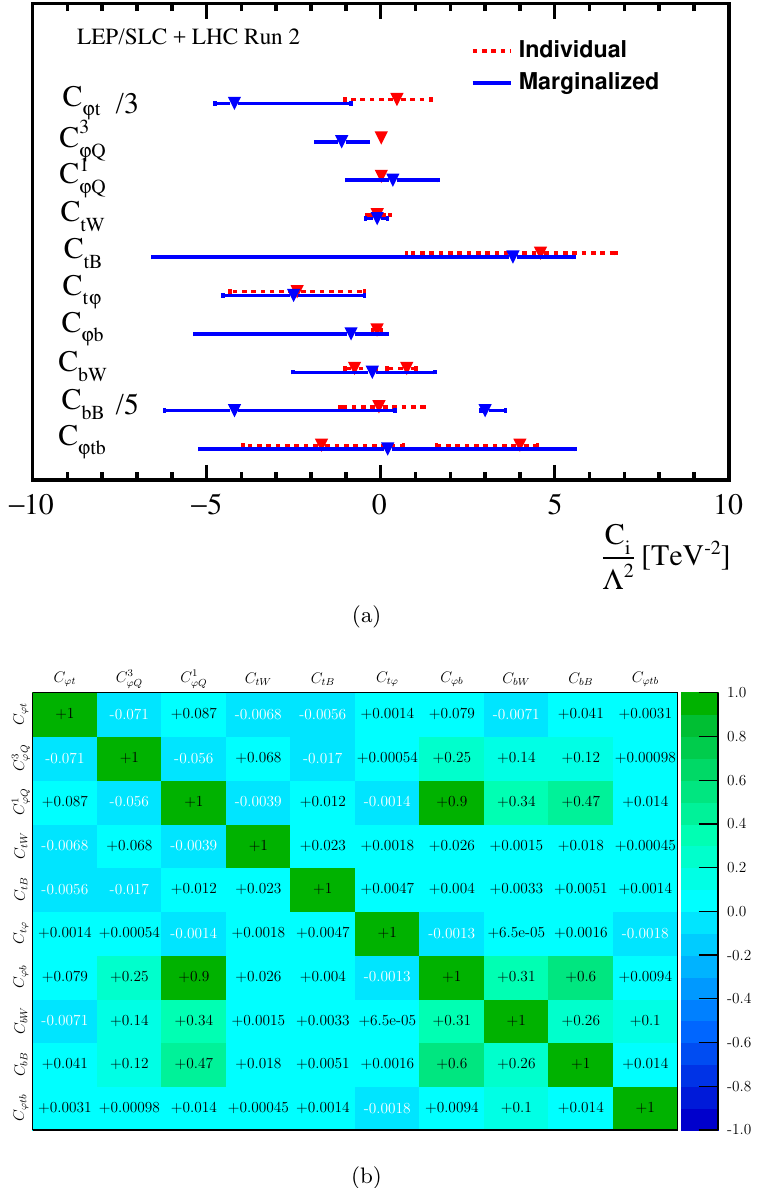
Figure 2 . The 68% C.L. limits (upper panel) and correlation matrix (lower panel) for the Wilson coe(cid:14)cients of the ten e(cid:11)ective operators that modify the EW couplings of top and bottom quarks derived from a (cid:12)t of the data included in table 1. The correlation matrix in HEPfit is